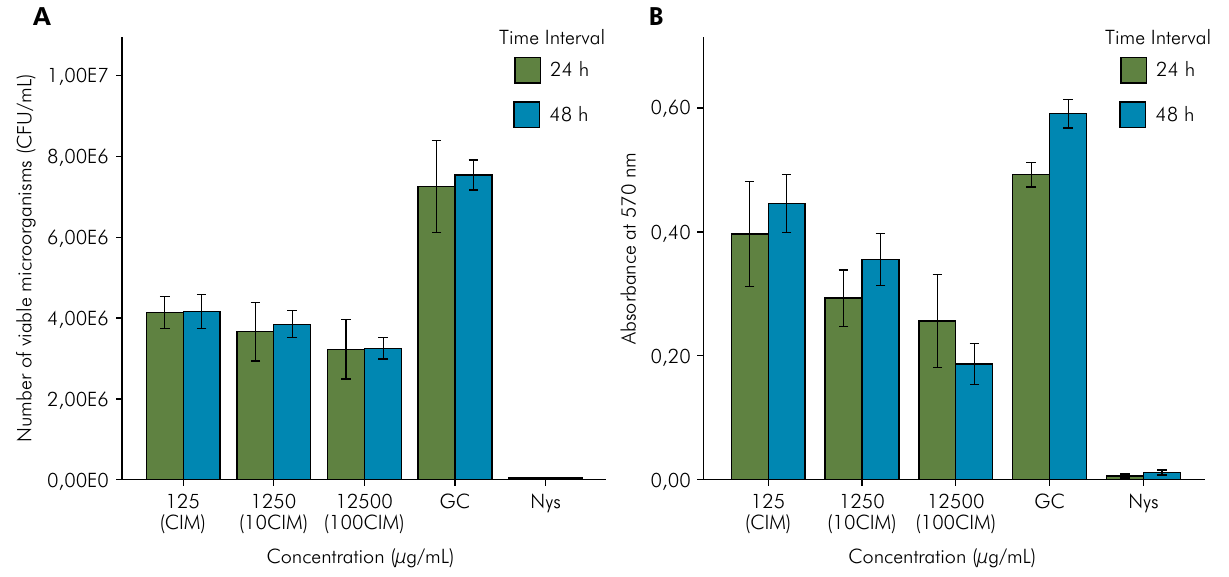
Figure 1. Cell viability and metabolic activity of C. albicans cells at 24 and 48 hours after exposure to different concentrations of extract from leaves of G.